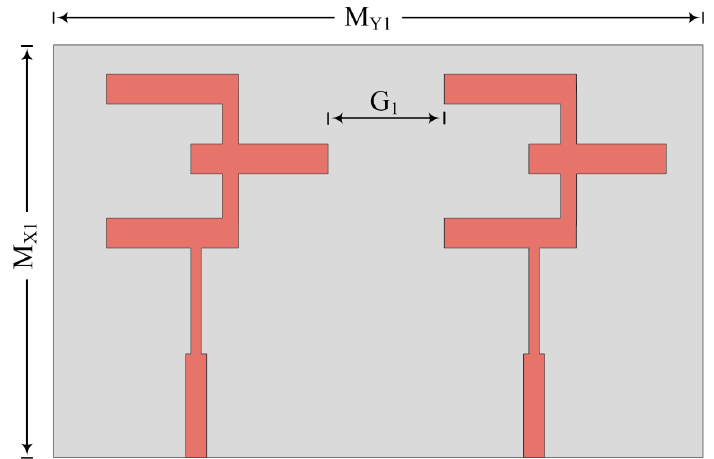
Figure 6. Schematic of MIMO antenna for parallel placement of elements.